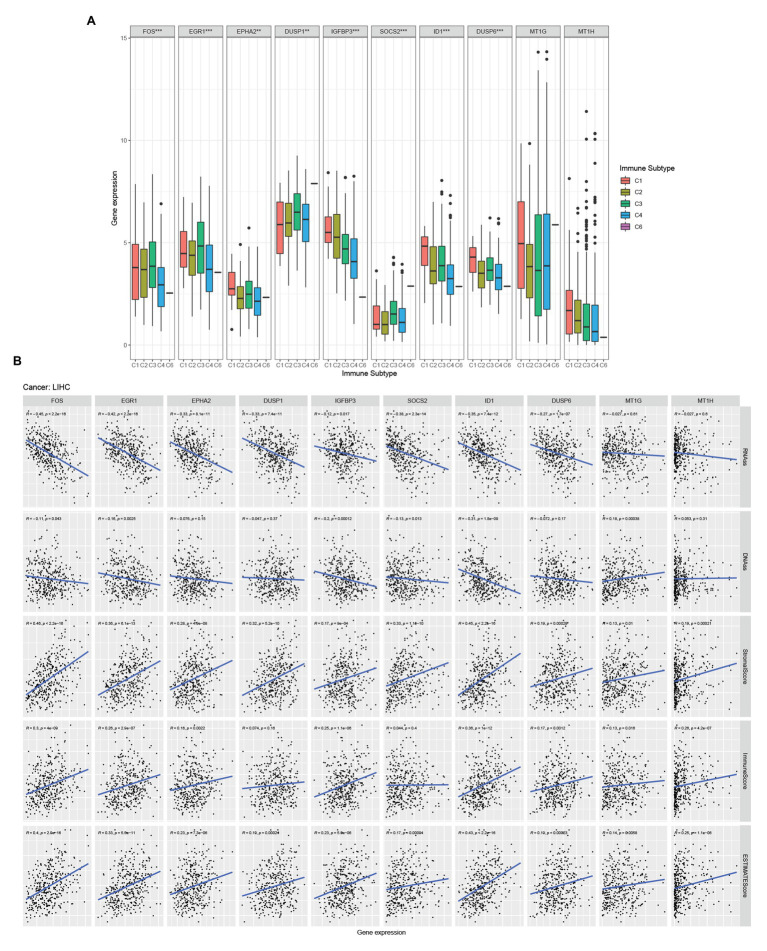
Hub genes and HCC microenvironment analysis. (A) Association of hub genes expression with immune infiltrate subtypes in HCC tested with ANOVA. (B) Correlation matrixes between hub gene expression and RNAss, DNAss, stromal score, immune score, and Estimate Score. Spearman correlation tests were used for testing.